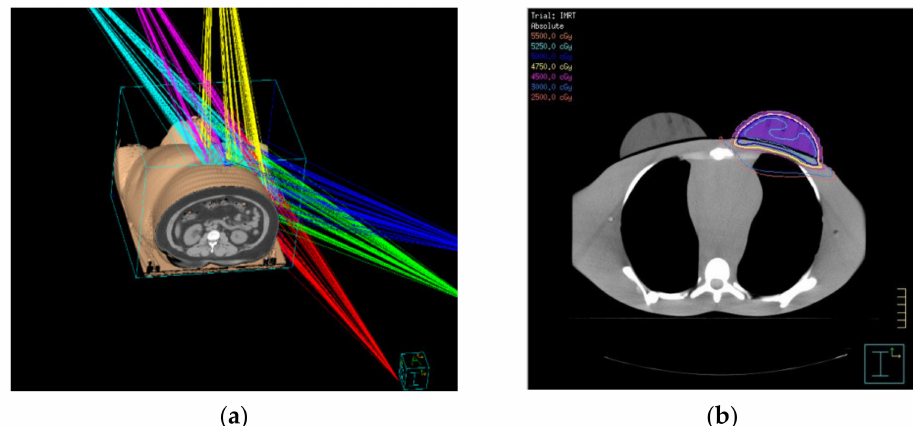
Figure 2. Treatment planning using intensity-modulated radiotherapy (IMRT) ( a ) Whole breast irradiation scheme. (6 fields). ( b ) Dose distribution image. Yellow planning targeting area, purple tumor